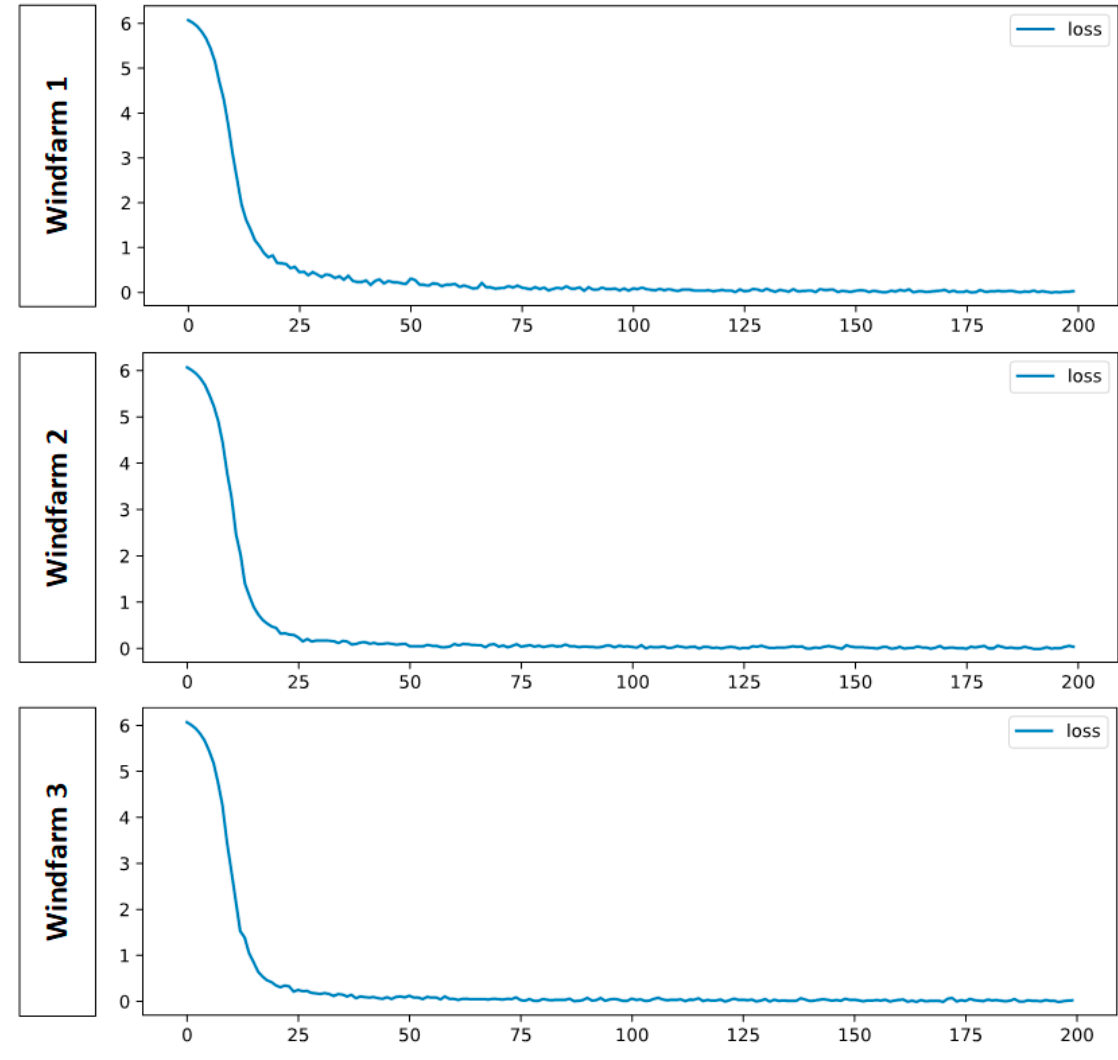
Figure 9. Accuracy Loss distribution on 200 Epochs for Windfarms 1, 2 and 3.